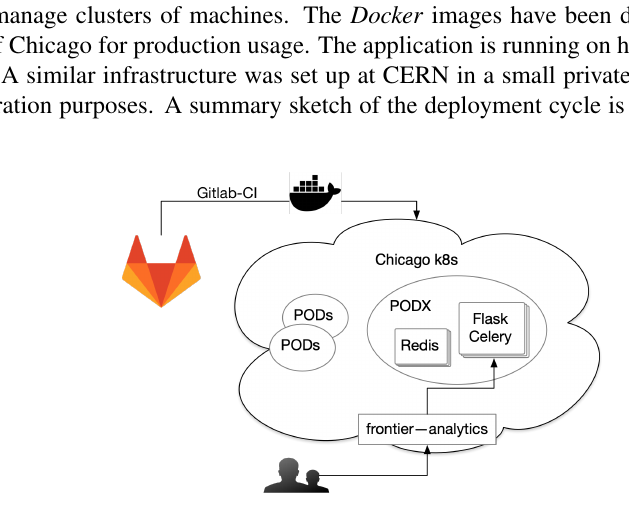
Figure 3. ATLAS Frontier Analytics